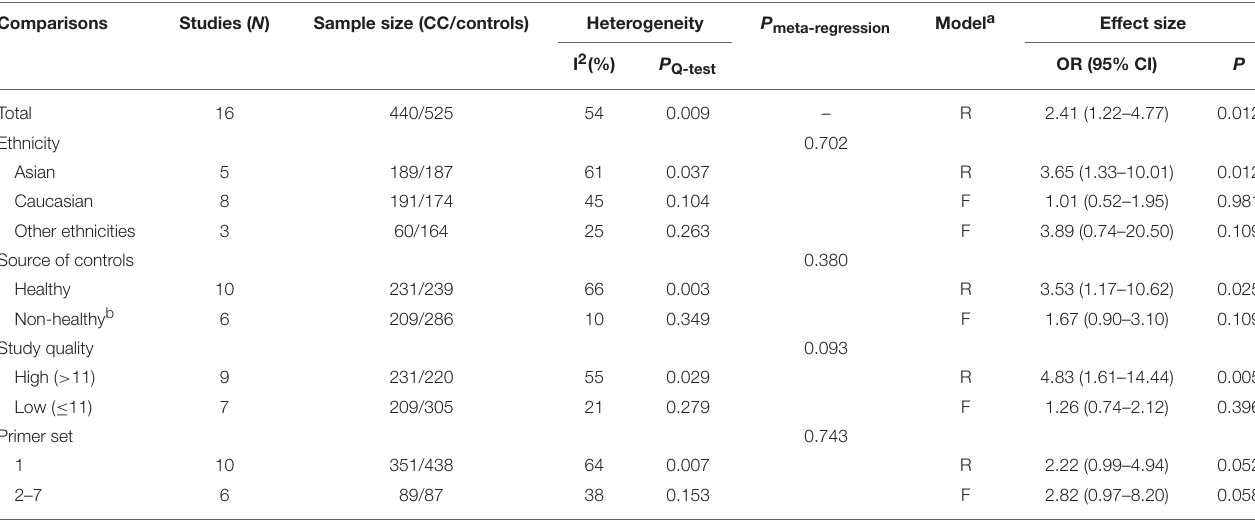
TABLE 2 | Pooled results for the association of DAPK1 promoter hypermethylation with LSIL risk. Comparisons